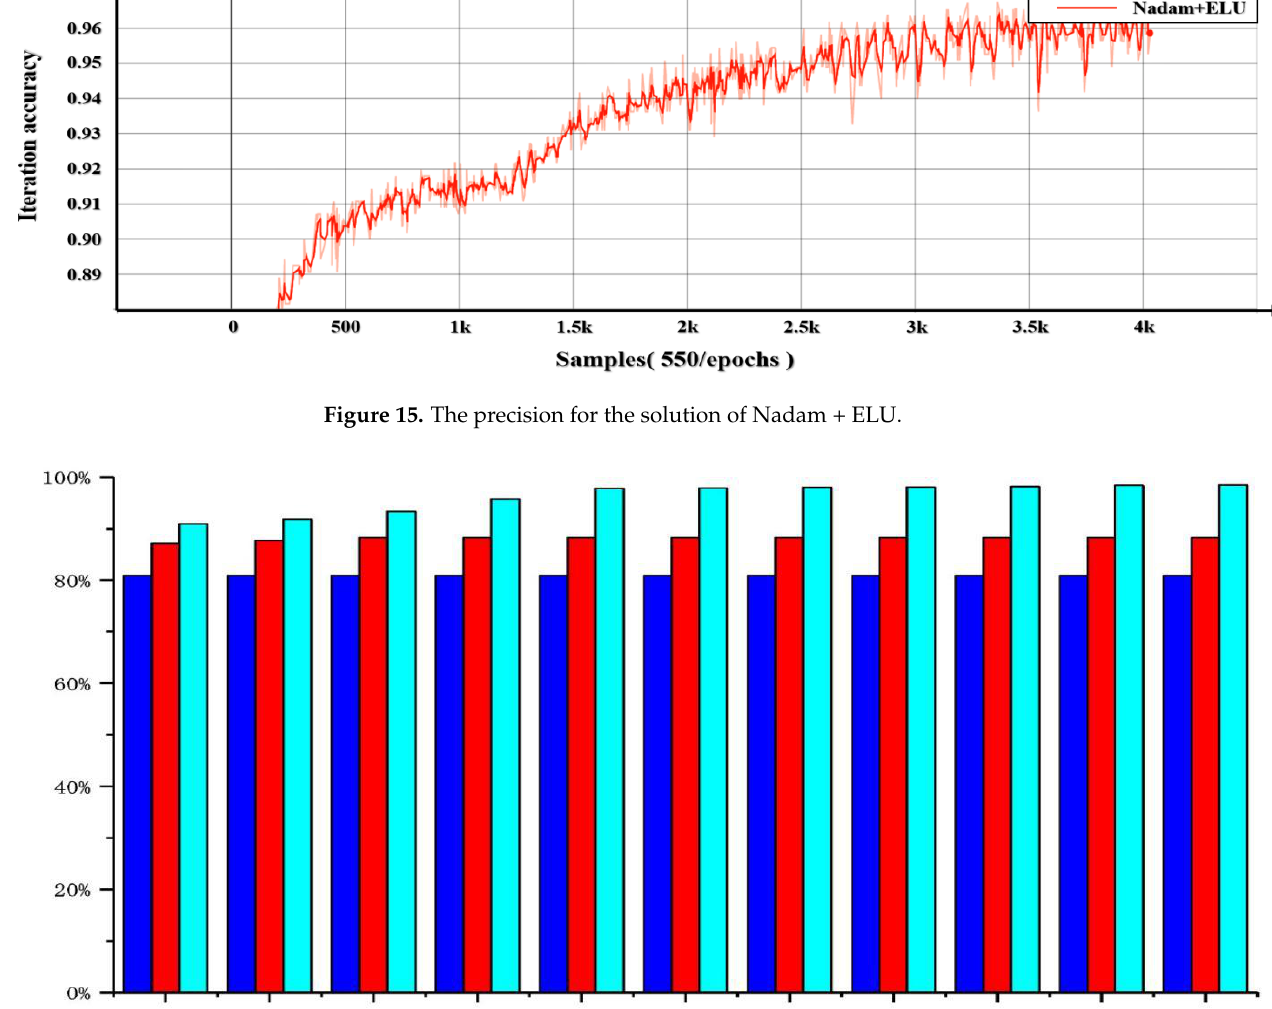
Appl. Sci. 2023 , 13 , x FOR PEER REVIEW 22 of 28